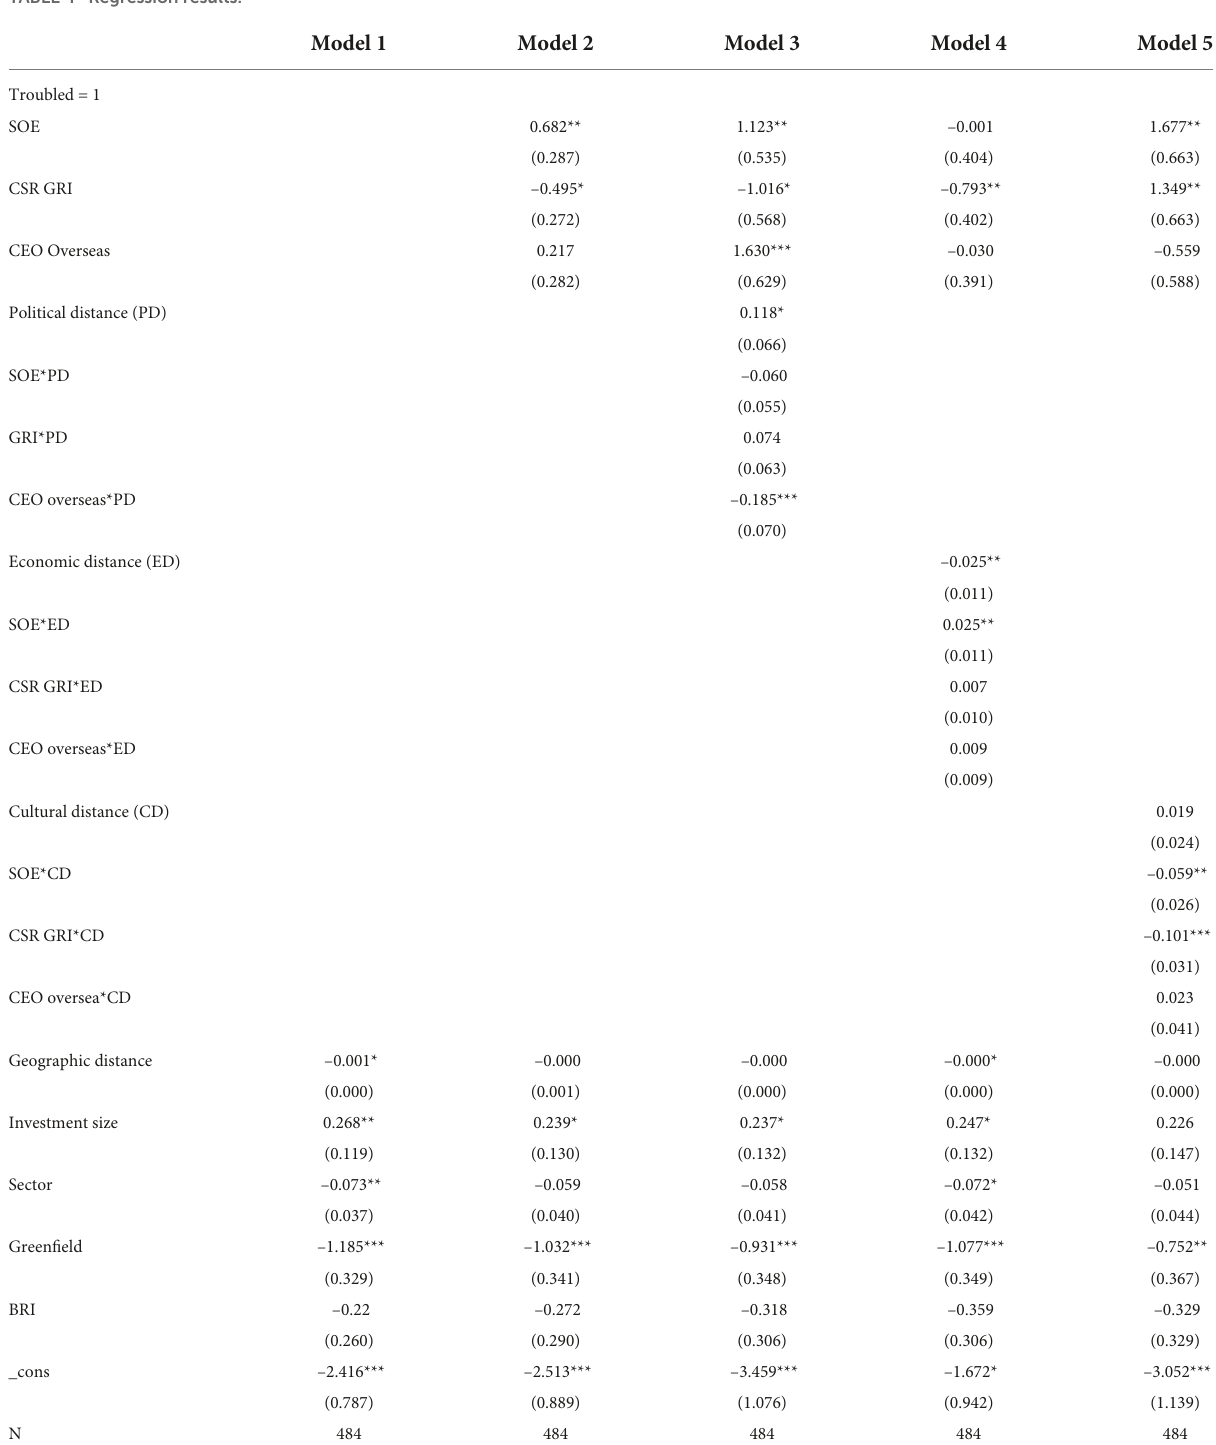
TABLE 4 Regression